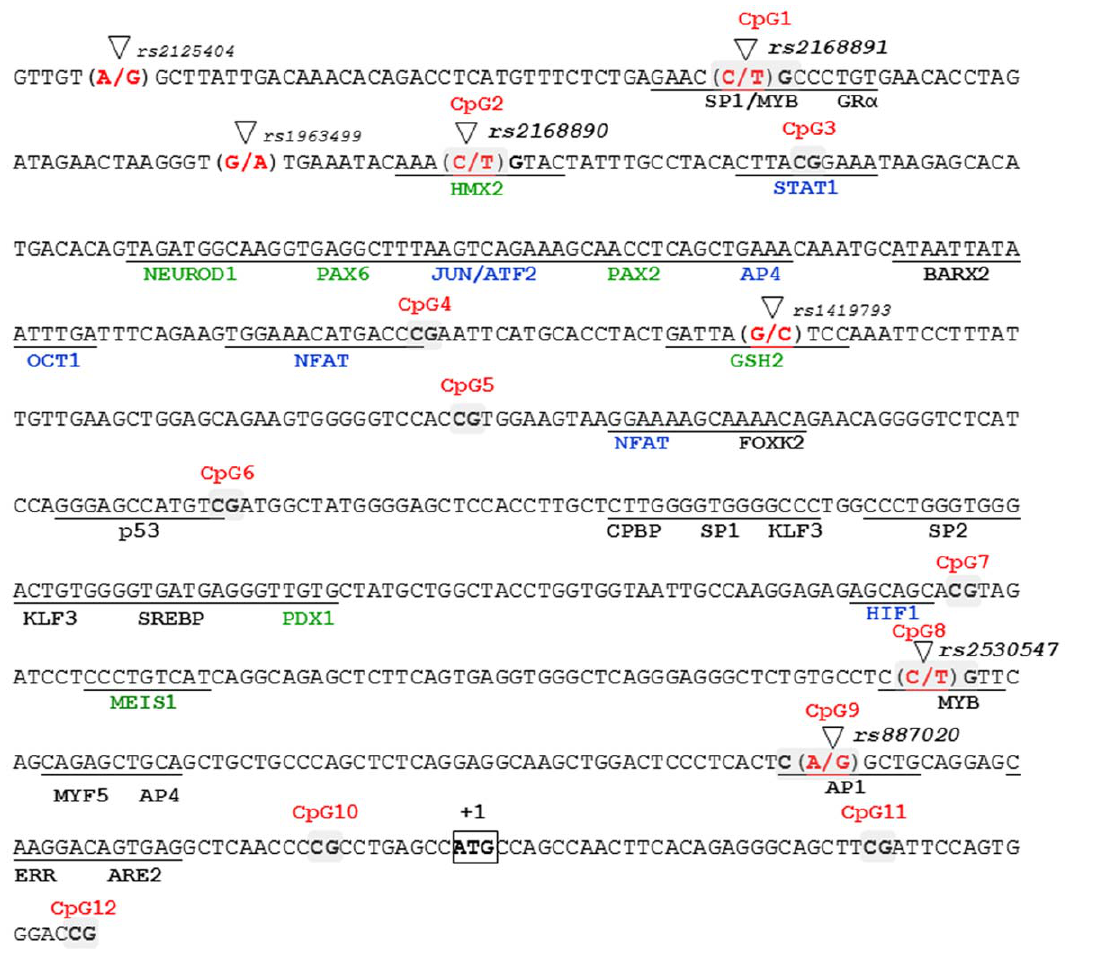
Figure 1. The promoter region of the Neuropeptide S Receptor 1 gene ( NPSR1 ). Polymorphisms are marked by triangles, transcription factor binding sites are underlined and CpG sites are shaded in gray. Green color of the transcription factor indicates neurologically associated factors, blue indicates immunologically associated factors, and black indicates general factors.